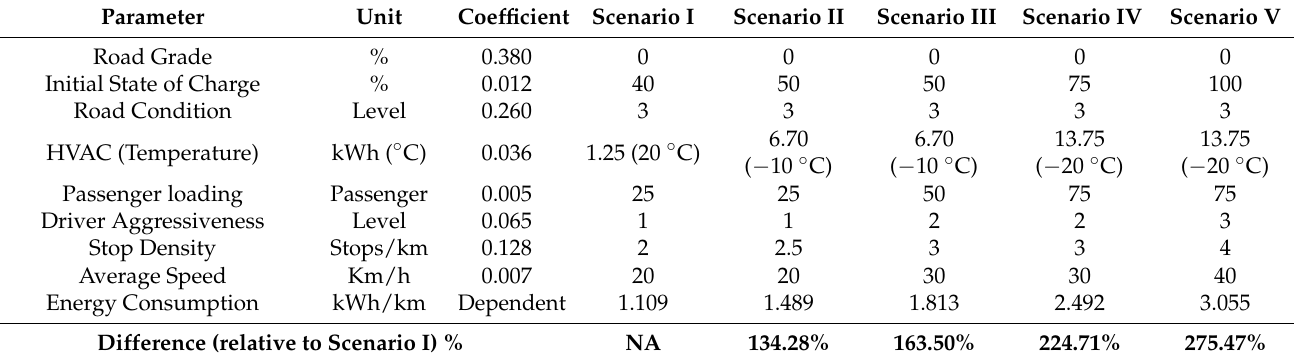
Table 8. Energy consumption scenarios for BEB route